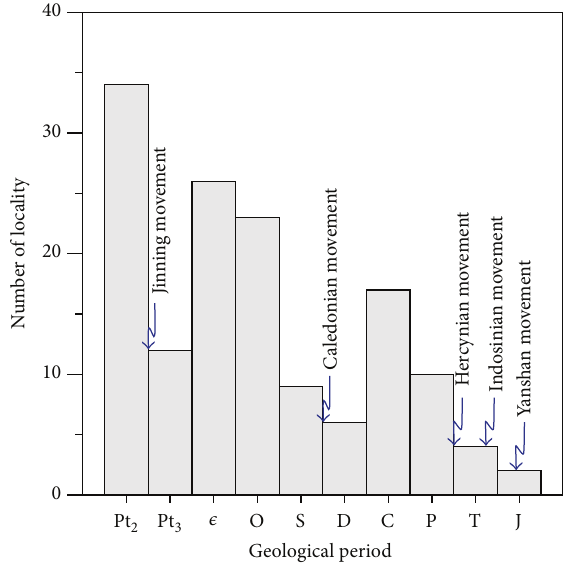
Figure 6: Column diagram of number for localities of siliceous rocks in the COB (data were calculated from literatures [32,